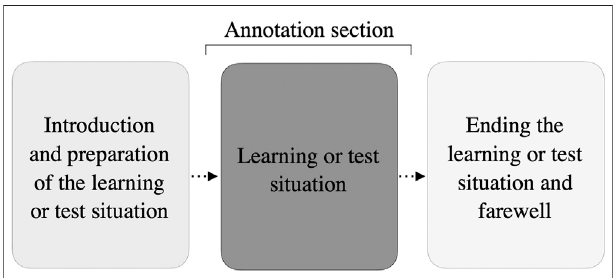
FIGURE 3 | Sequence of the interaction during sessions and annotated